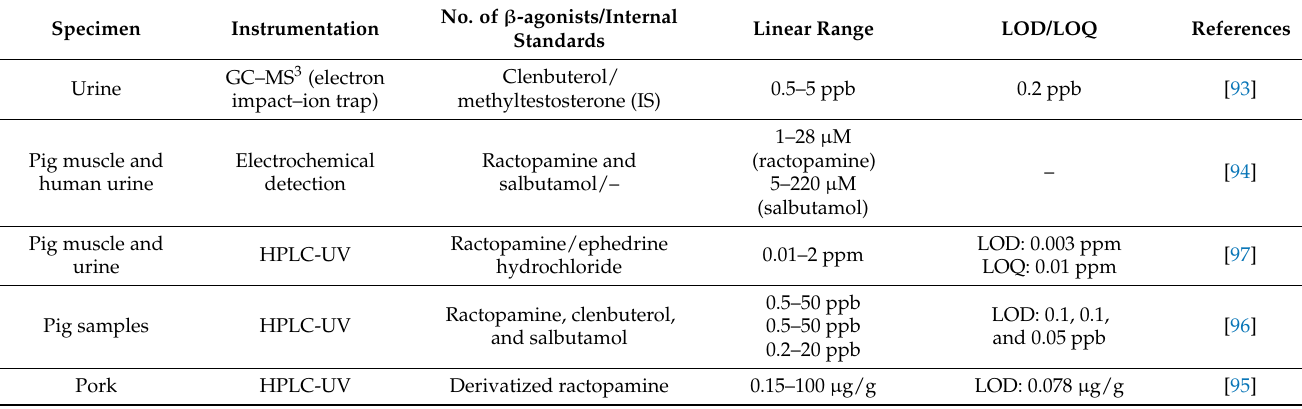
Table 3. Summary of the methods used to measure ractopamine content in